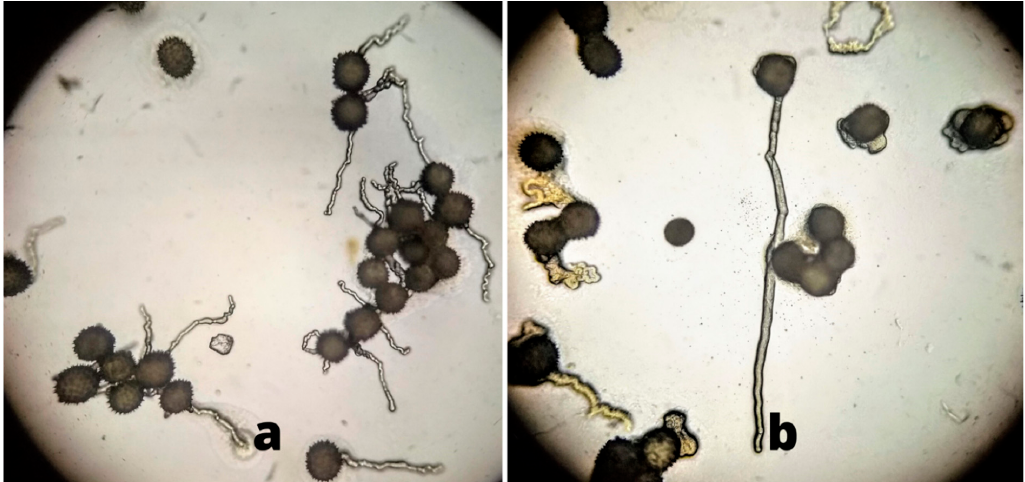
Figure 5. The observed variation in pollen tube germination where ( a ) Bottom flowers from AA-933 showed maximum pollen germination ( b ) Top flowers from N-1048 showed lowest pollen germination. Table 5. Mean values for six measures of heat tolerance in 13 cotton genotypes grown in 2019 in Faisalabad, Pakistan. Genotypes